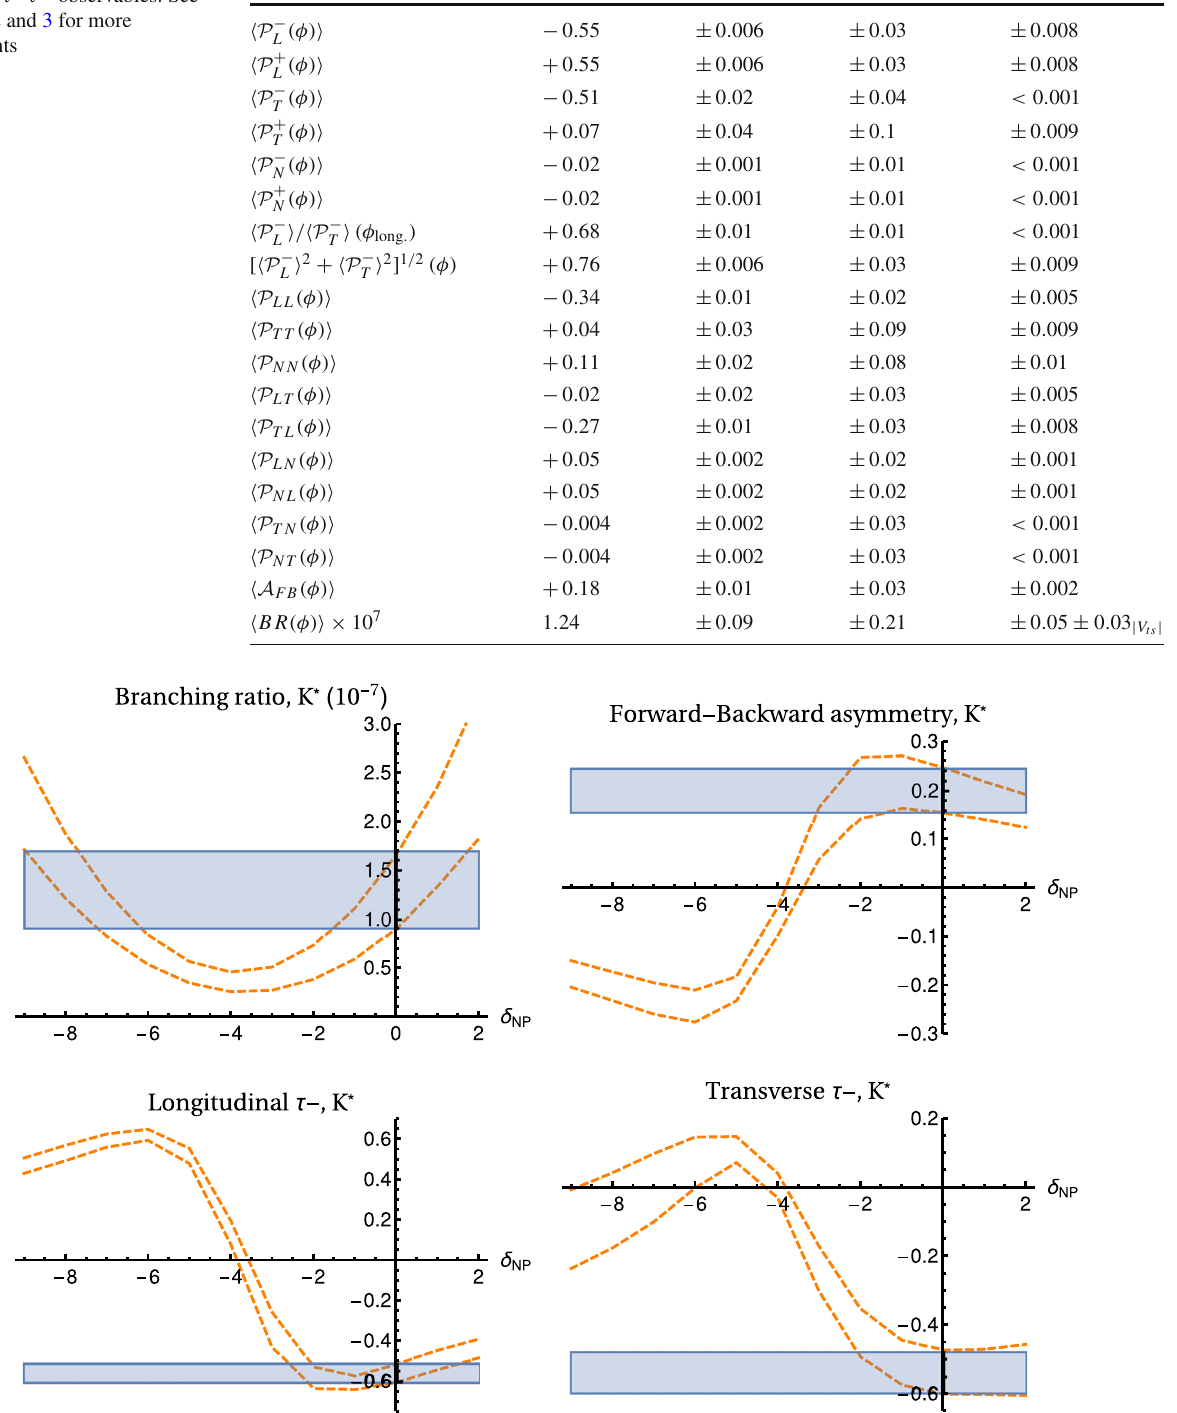
Table 4 SM predictions for ¯ B → φτ + τ − observables. See s